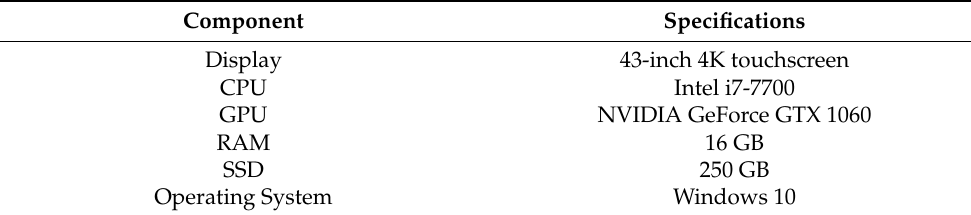
Table 1. Touchscreen hardware specifications.